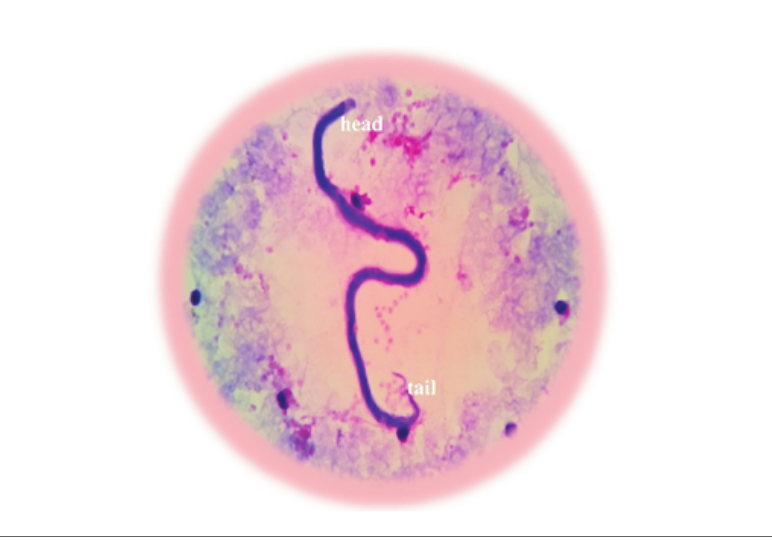
Figure 1. Full Size Microfilaria Wuchereria Bancrofti seen on thick blood smear, stained with Giemsa and focused under oil immersion (100×10)